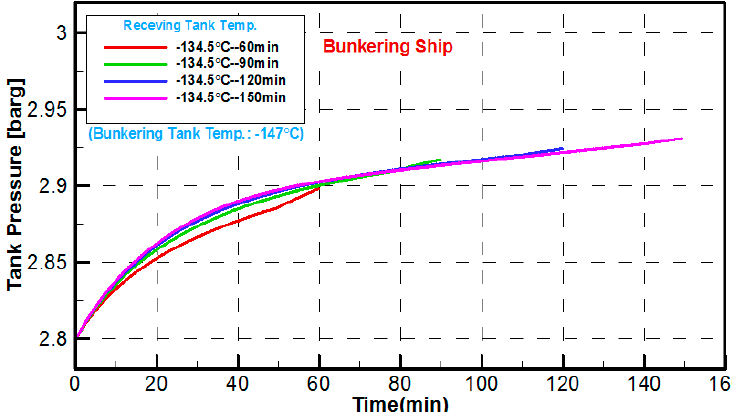
Figure 7. Pressure variation in the bunker cargo tank of the bunkering ship during the bunkering operation at different bunkering time limits.